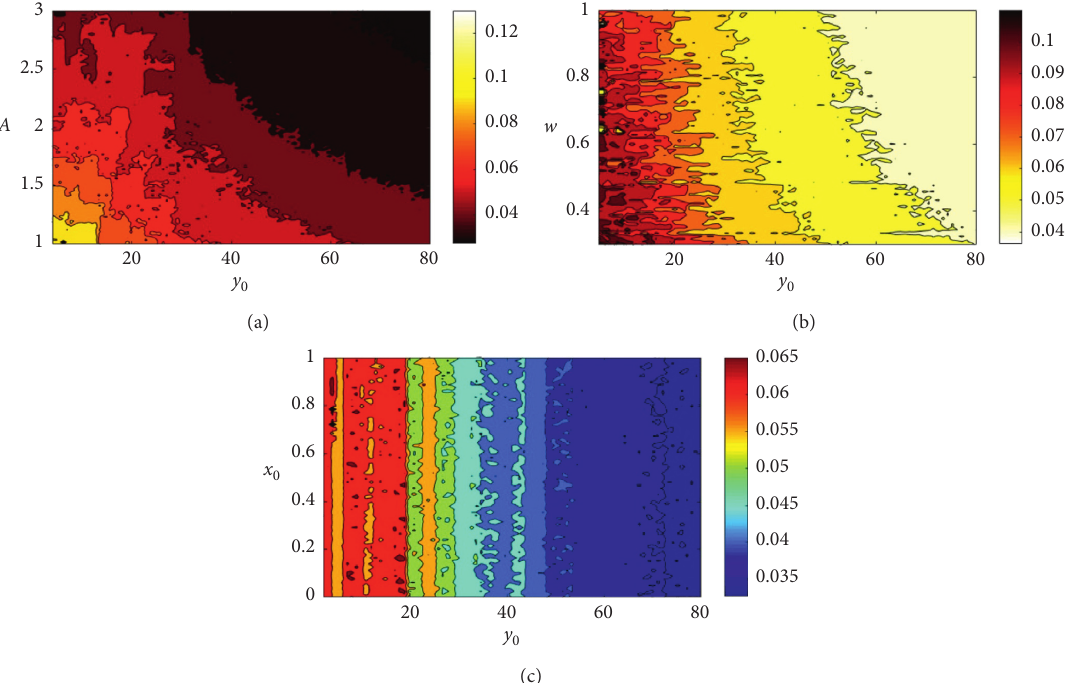
Figure 7: Complexity values of the system (equation (3)) calculated by SamEn. (a) w � 0 . 5, and the initial values are set ( 0 ,y and the initial values are set ( 0 . 01 ,y